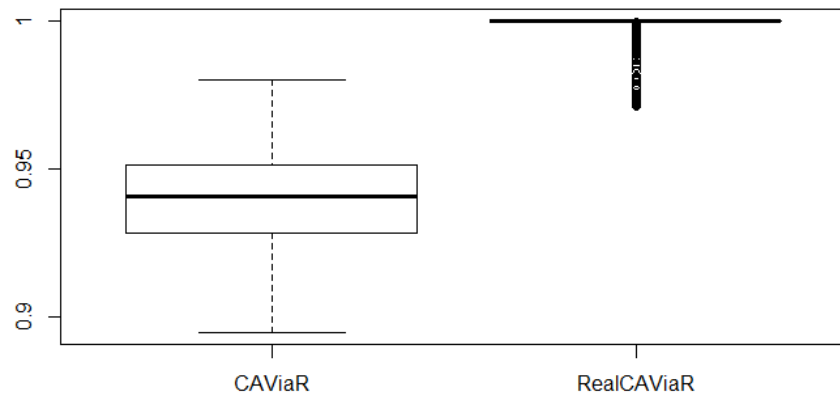
Figure 4. Estimates of the extremal index on the volatility